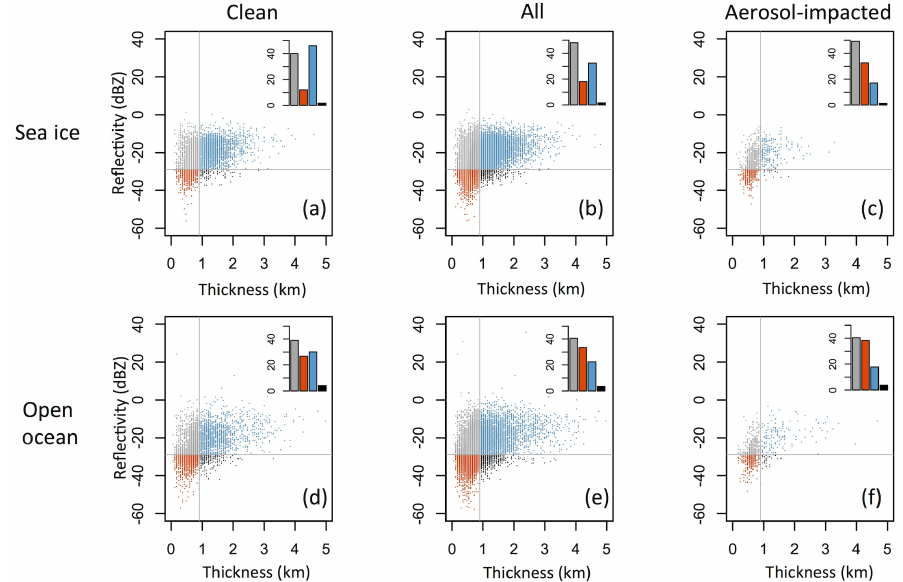
Figure 5. A comparison of CALIPSO ONLi cloud thickness (km) with CloudSat reflectivity (dBZ), as separated by sea ice and open-ocean regimes, and by clouds found in conditions labeled as clean background conditions, all conditions, and aerosol-impacted conditions. To better show changes in the two parameters, plots have been divided into four quadrants (above (grey and blue) and below (orange and black) the CloudSat reflectivity detection limit of − 29dBZ), and above (blue and black) and below (orange and grey) a thickness of 0.9km. In the upper right of each plot is shown the percentage of cases within each quadrant, following the quadrant color scheme. Points represent clouds >